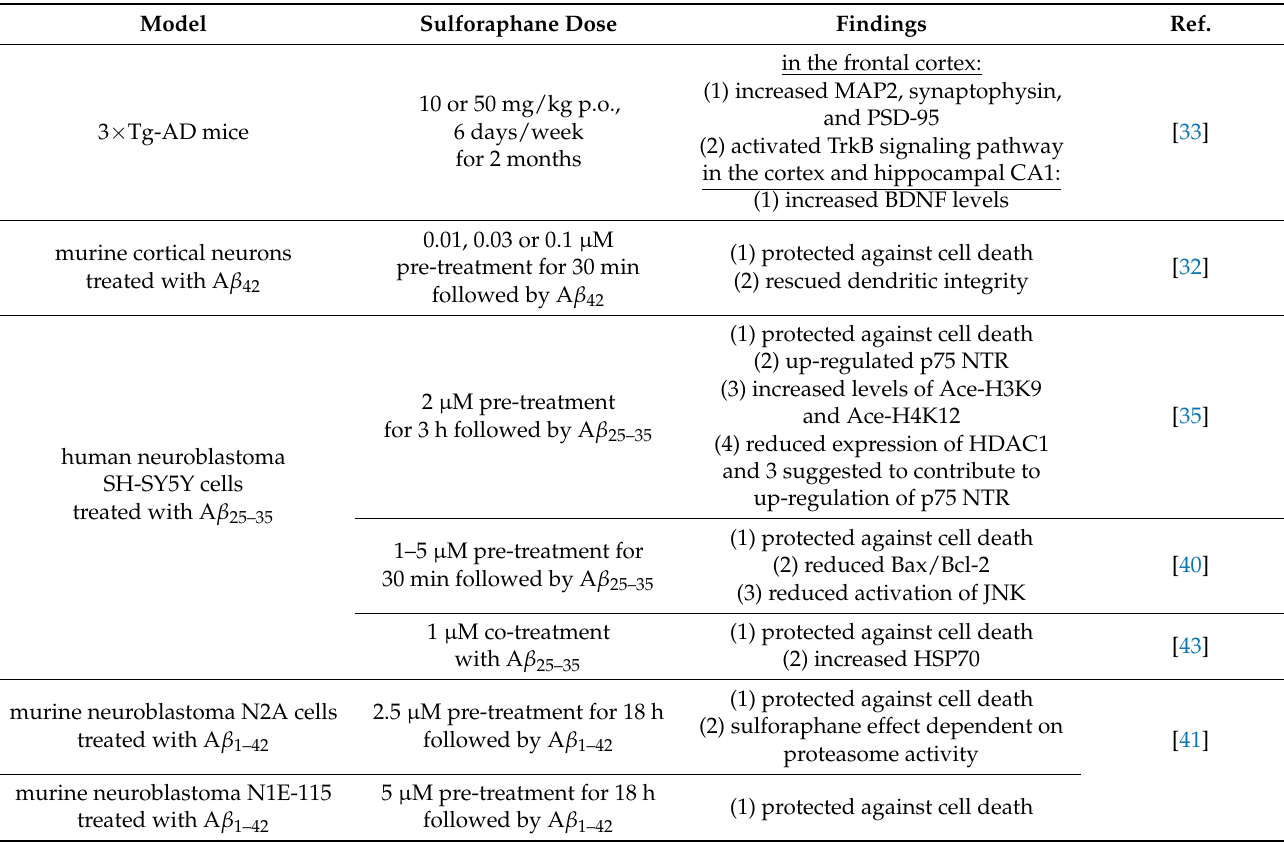
Table 5. The effects of sulforaphane on Alzheimer’s disease (AD)-associated biomarkers of synaptic damage and neurode- generation such as cell death in AD-like models. Model Sulforaphane Dose Findings Ref.